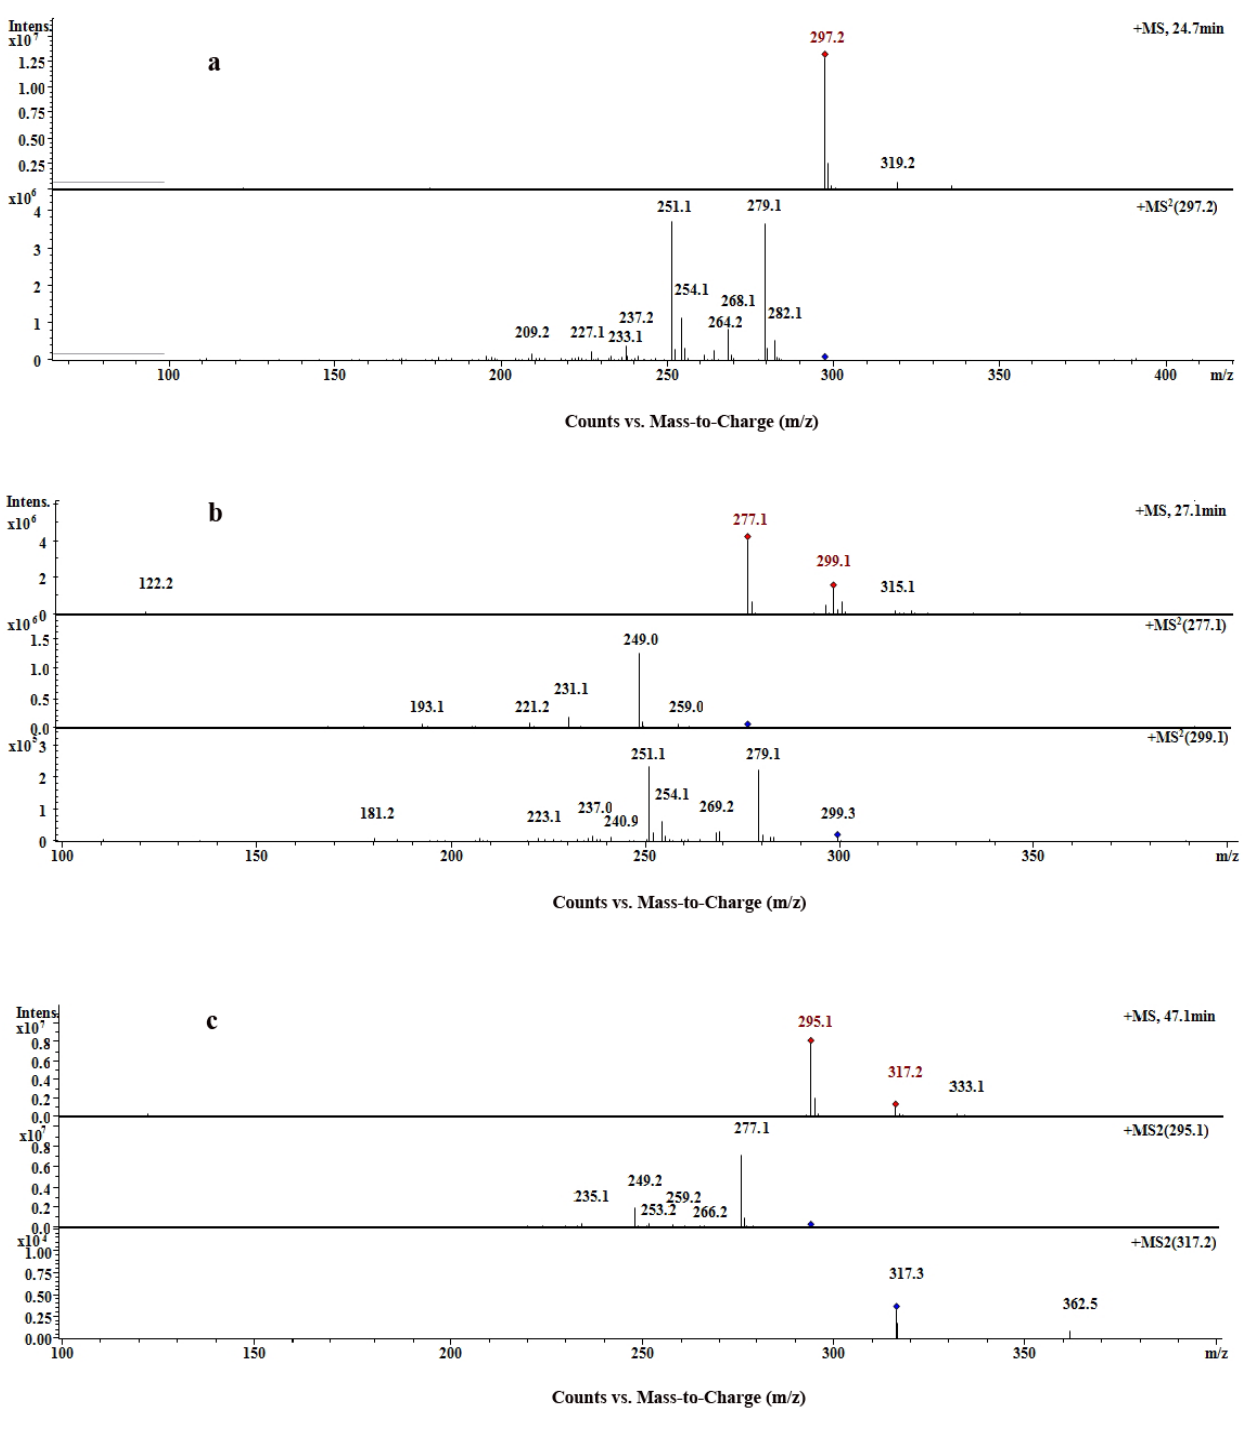
Figure 4. ( a ) MS/MS spectra of compound 1 at 24.7 min. ( b ) MS/MS spectra of compound 2 at 27.1 min. ( c ) MS/MS spectra of compound 3 at 47.1